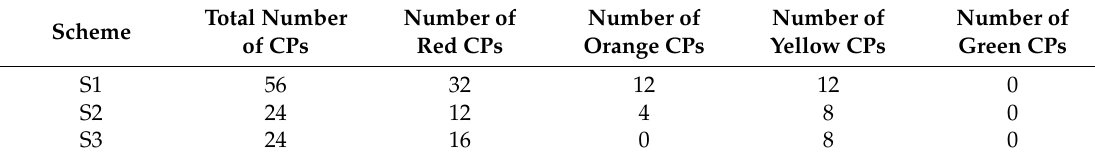
Table 3. Analysis of conflict points at S1, S2, and